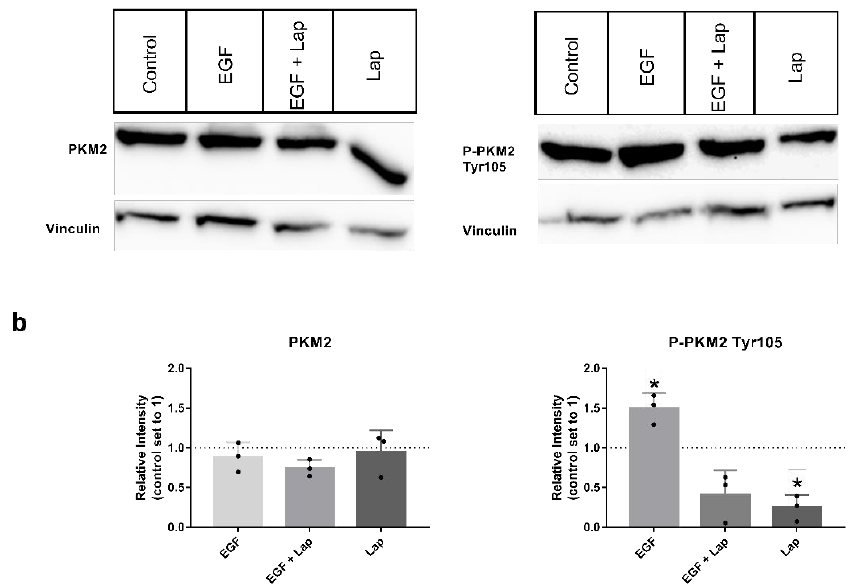
Figure 2. EGF stimulation and lapatinib treatment have an impact on levels of P-PKM2 (Tyr105). ( a ) PKM2 ( left ) or P-PKM2 Tyr105 ( right ) specific Western blots of Detroit 562 cells stimulated for 48 h with 8.3 nM EGF, 8.3 nM EGF in presence of 10 µ M lapatinib (EGF + Lap), 10 µ M lapatinib only (Lap) or with vehicle alone (Control). Vinculin was used as a loading control. ( b ) Western blot intensities relative to untreated control. Shown are mean values and SD of three independent experiments as depicted in ( a ). Vinculin intensities were used for normalization. *: p < 0.05, one sample t - test.